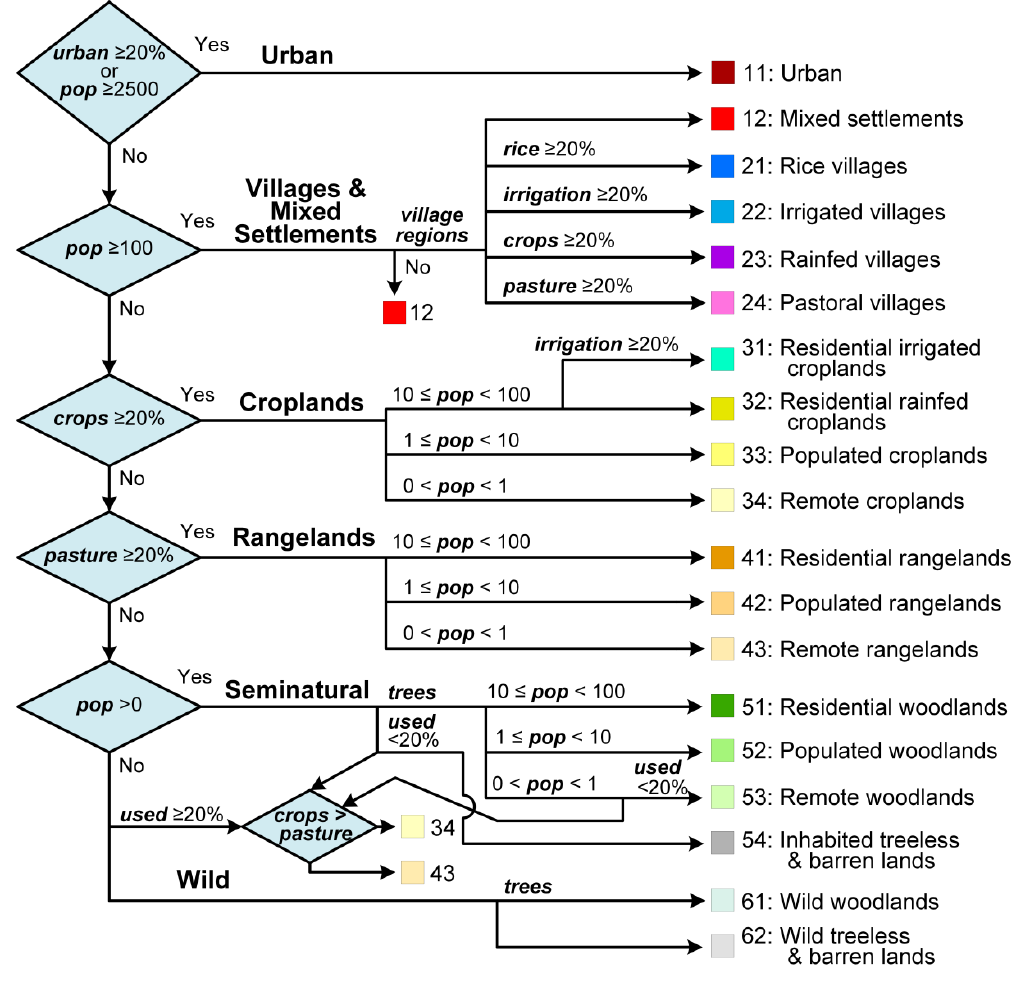
Figure A1. Anthromes v2.0 classification flowchart.